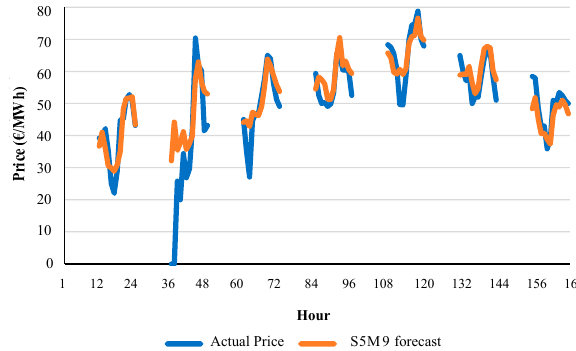
Figure 11. Actual price values and forecast values of model S5M9 of intraday session 5 for week 7 of year 2013.